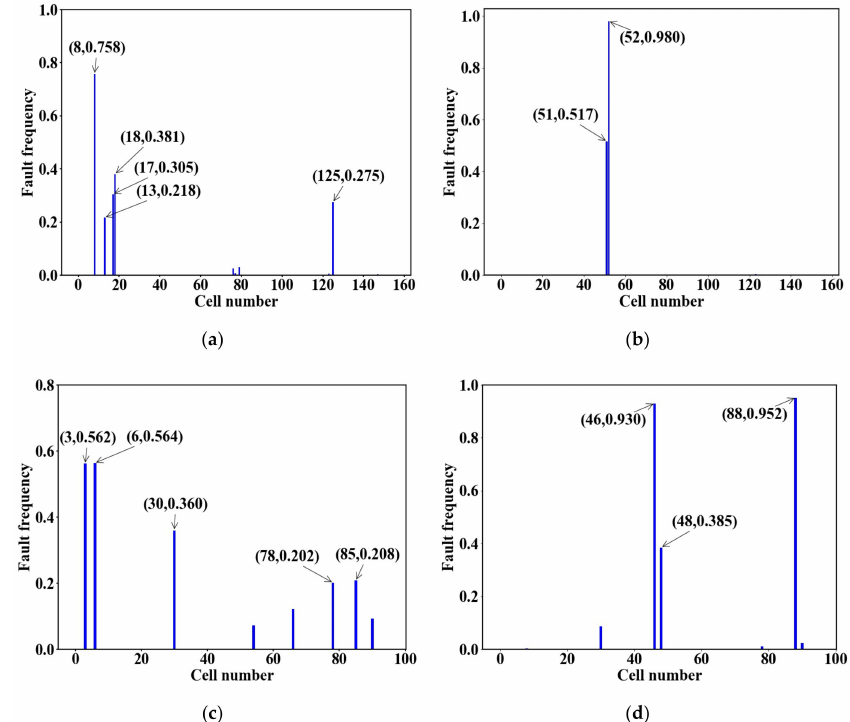
Figure 12. Fault frequencies by 3r-MSS of battery cells in: ( a ) vehicle 1; ( b ) vehicle 2; ( c ) vehicle 5; ( d ) vehicle